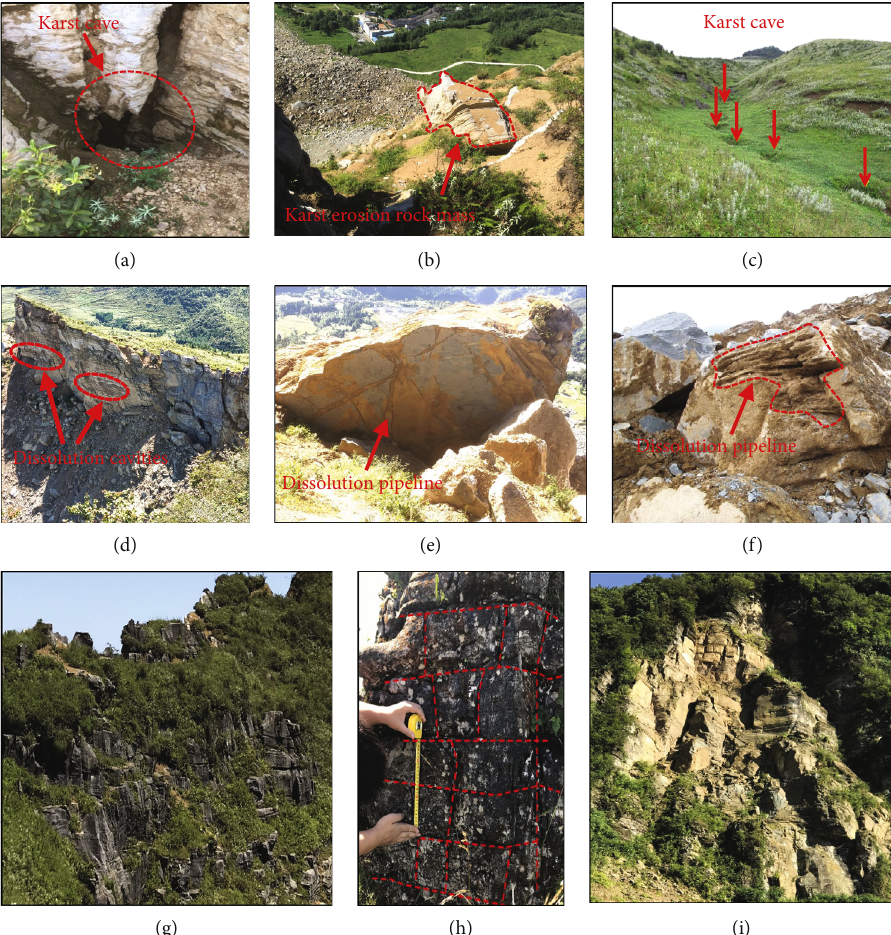
Figure 3: Typical erosion signs and rock structure of collapse source area: (a) karst cave; (b) karst erosion rock mass in source area; (c) karst cave behind the mountain; (d) dissolution cavities in sliding surface; (e) dissolution pipeline in source area; (f) dissolution pipeline in deposition area; (g) block structure behind the landslide; (h) joint size of blocks behind the mountain; (i) block structure of local collapse on the left of